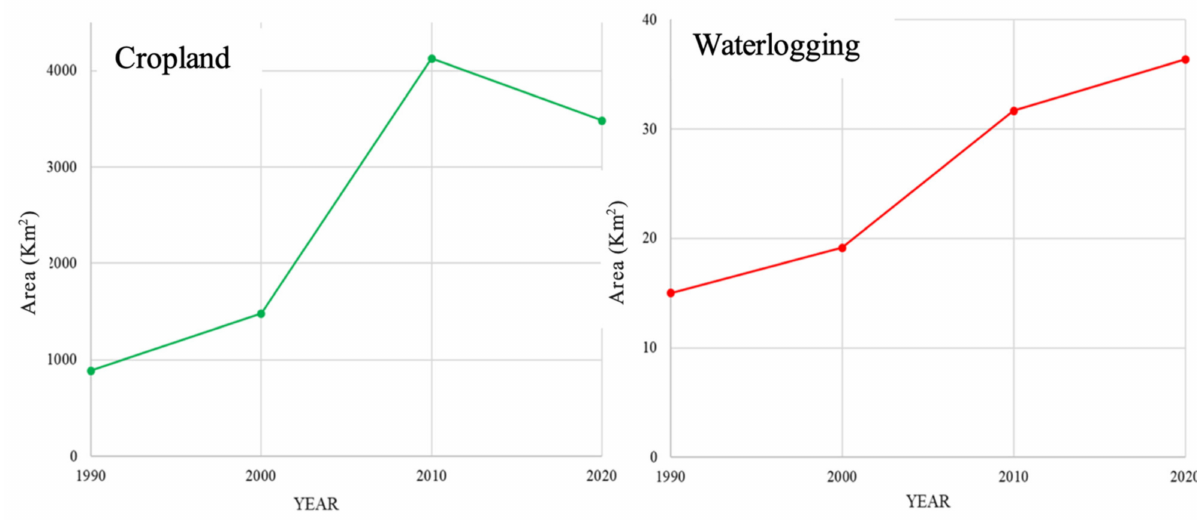
Figure 6. Charts showing the growth of croplands and waterlogging from 1990 to